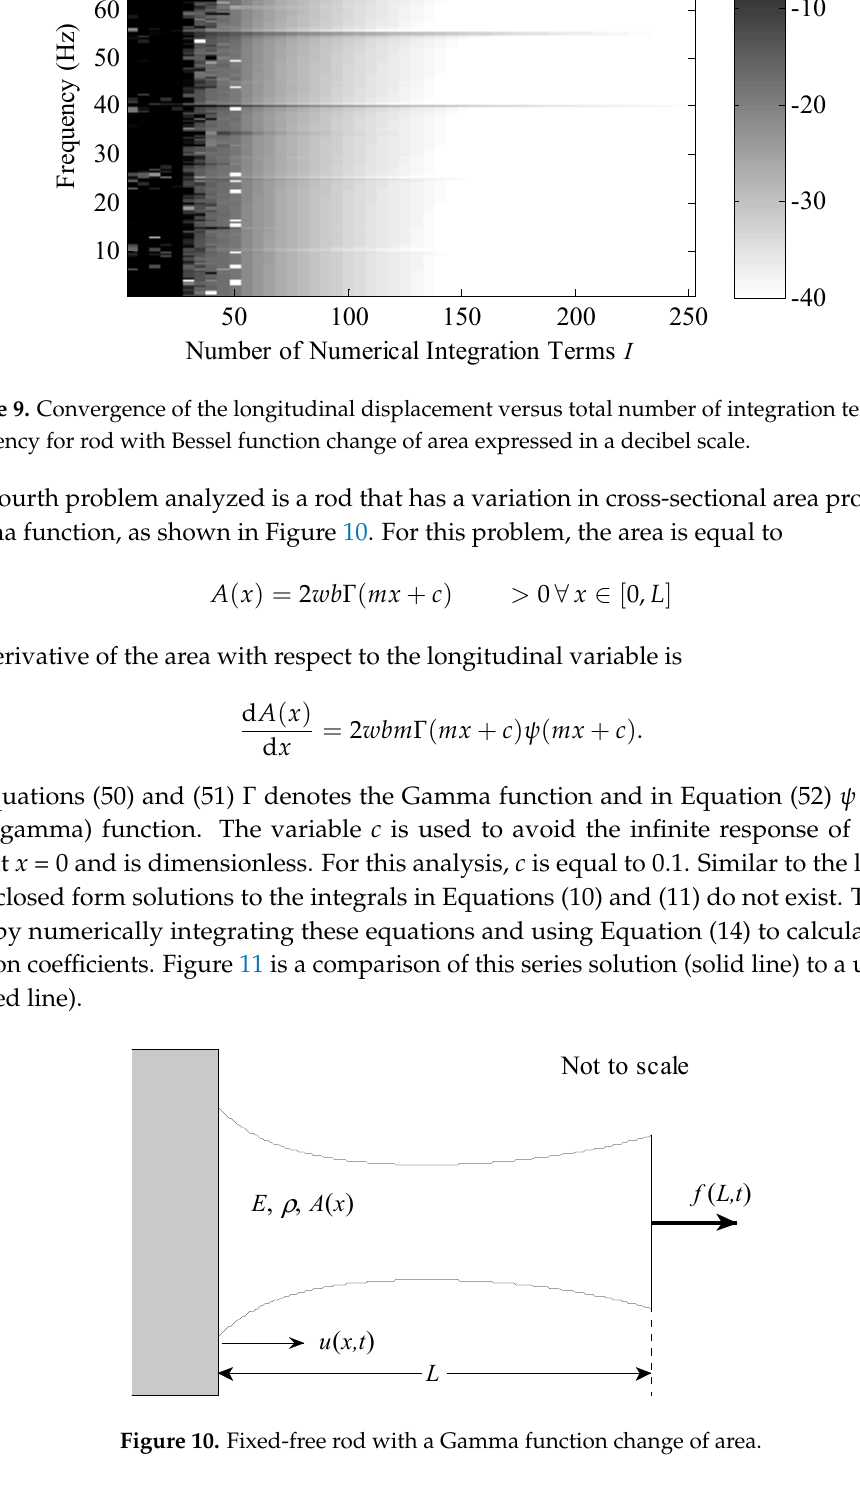
and the dashed line is the baseline model with uniform cross-sectional area.